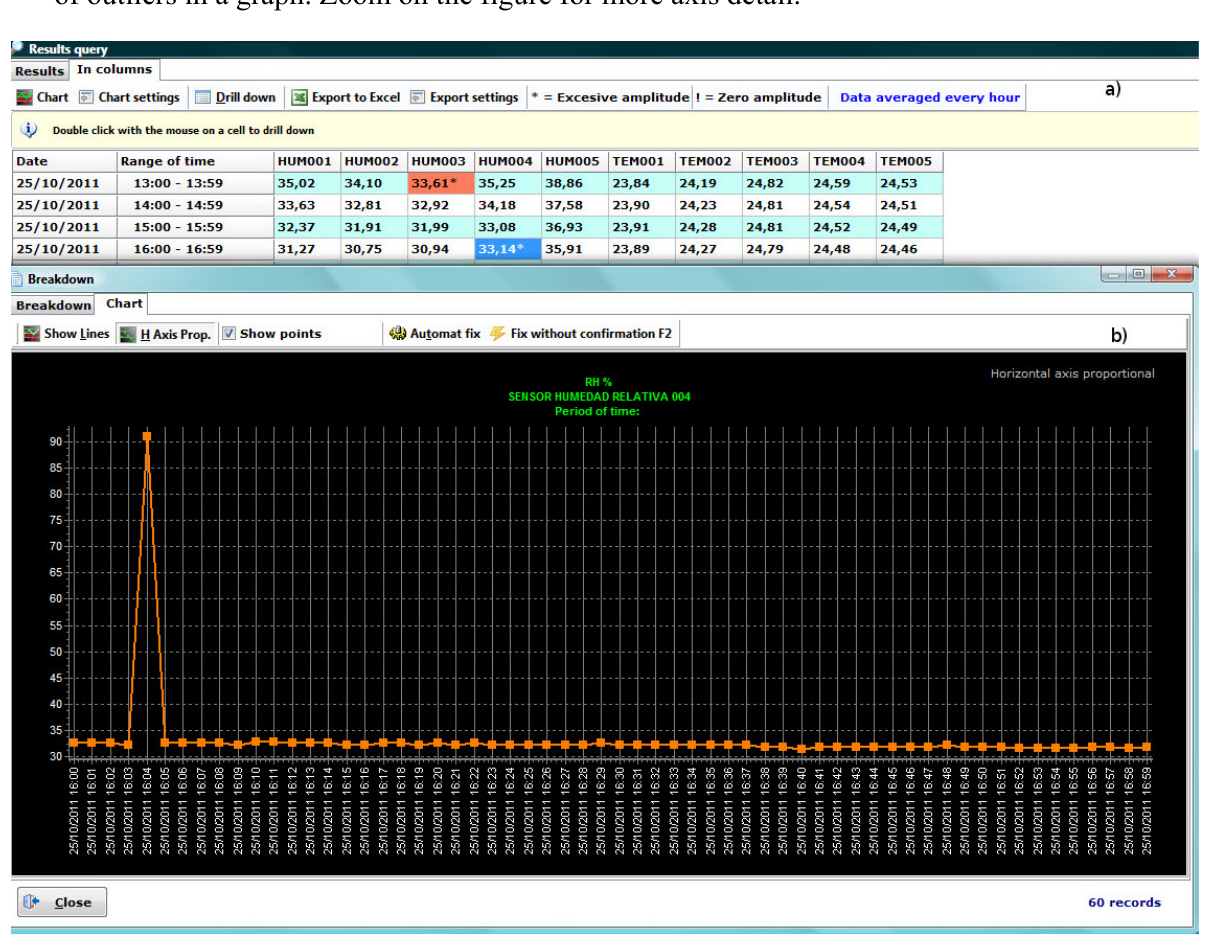
Figure 12. ( a ) Rapid localization of anomalous data in the columns view. ( b ) Localization of outliers in a graph. Zoom on the figure for more axis